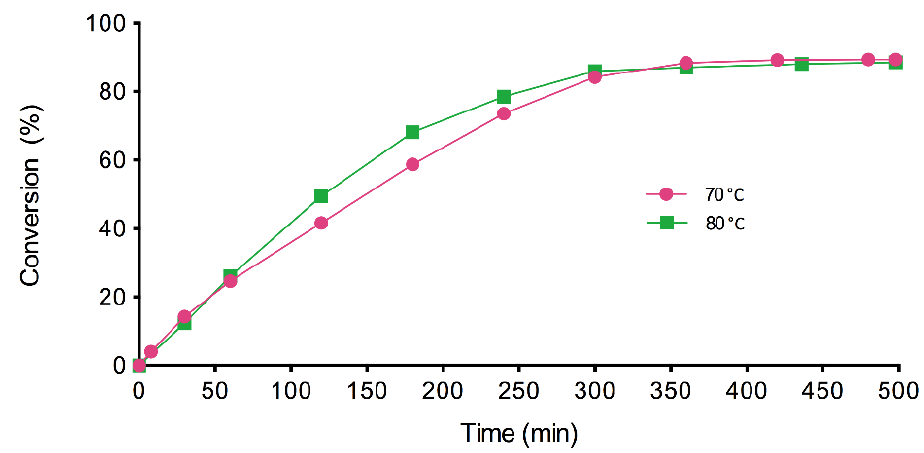
Figure 2. Conversion values of EHMH with time at 70 °C and 80 °C, 350 rpm, 2.5% (w/w) of biocat- alyst and a substrate molar ratio of